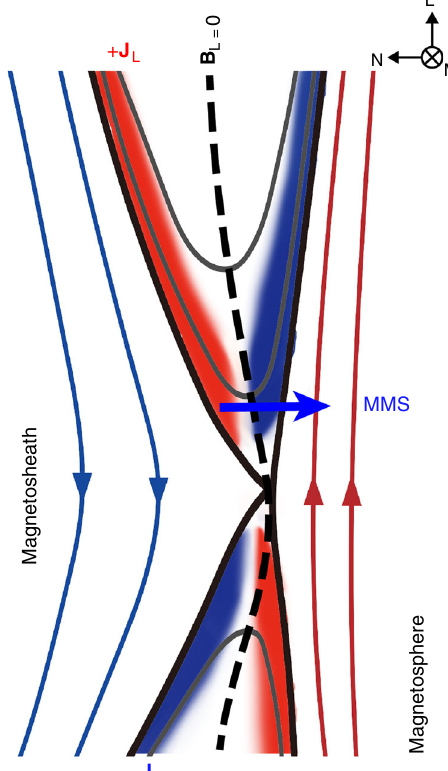
Fig. 2 Sketch of asymmetric reconnection with J shows the neutral line (de fi ned where B denotes the MMS trajectory near the electron diffusion region. The large- amplitude electron Bernstein waves are observed on the magnetosheath side of the neutral